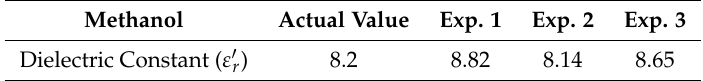
Table 2. Results of the sensor verification experiments for methanol dielectric